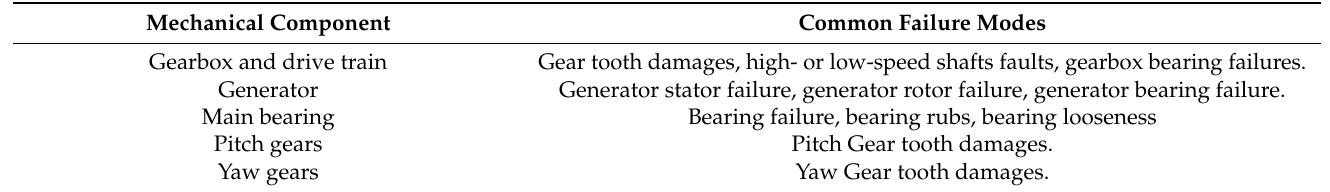
Table 3. Typical failure modes in wind turbine mechanical components, according to Ref.